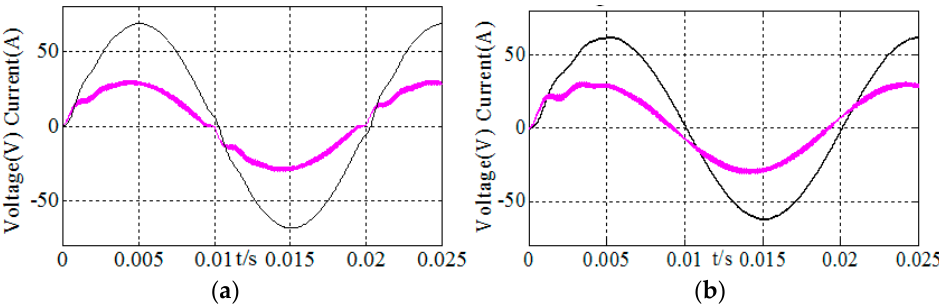
Modulation I. ( b ) Hybrid modulation mode (HMM).